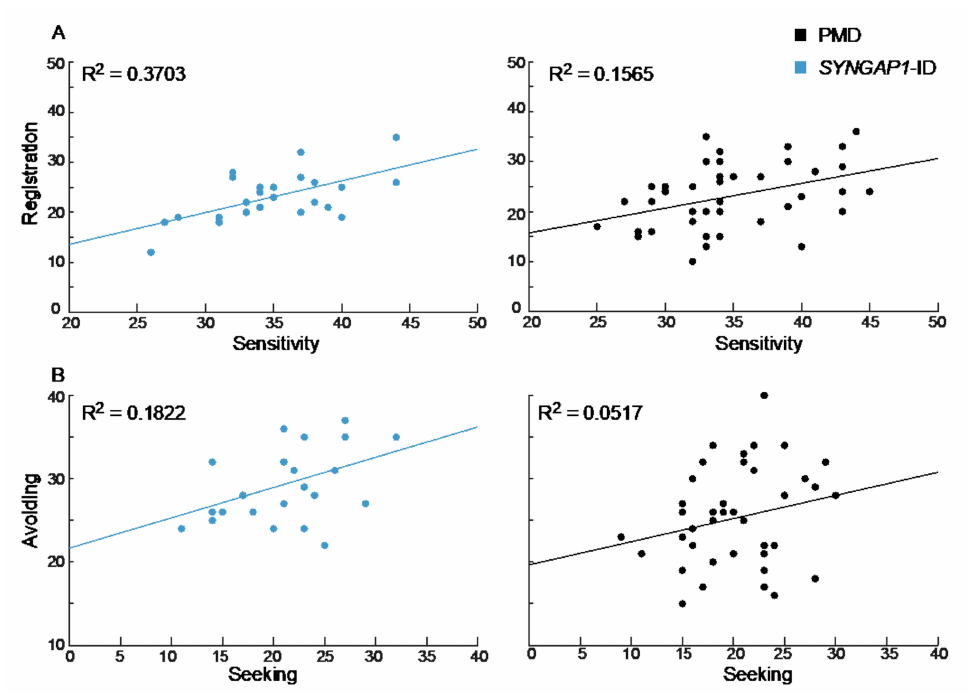
Figure 4. Correlation between sensory areas. ( A ) Registration and sensitivity scores for SYNGAP1 -ID (left, blue) and PMD (right, black) were more strongly correlated than ( B ) avoiding and seeking scores. PMD: Phelan-McDermid Syndrome. SYNGAP1 -ID: SYNGAP1 -related Intellectual Disability. SSP-2: Short Sensory